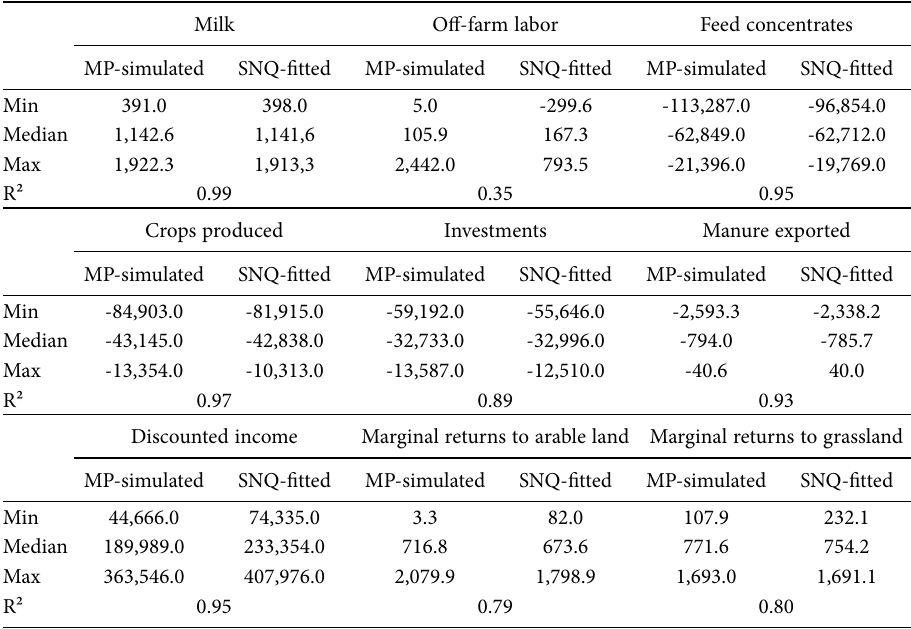
Table 2. Key descriptives of simulated and estimated